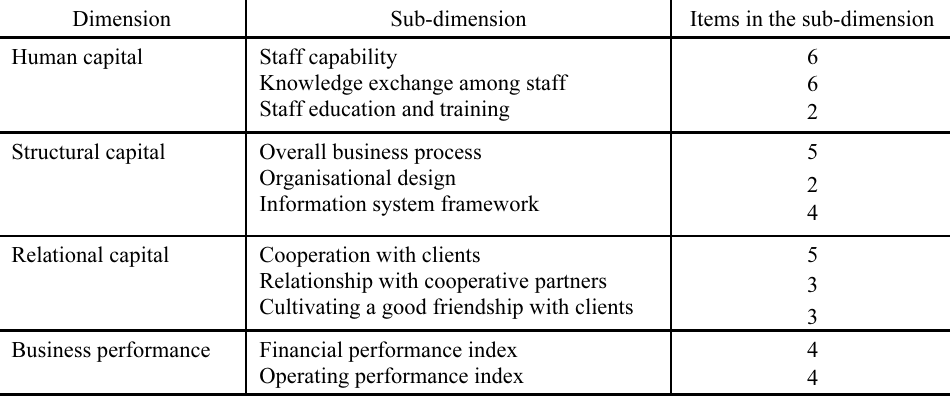
Table 1. Dimension, sub-dimensions and items of the measurement scale Dimension Sub-dimension Items in the sub-dimension Human